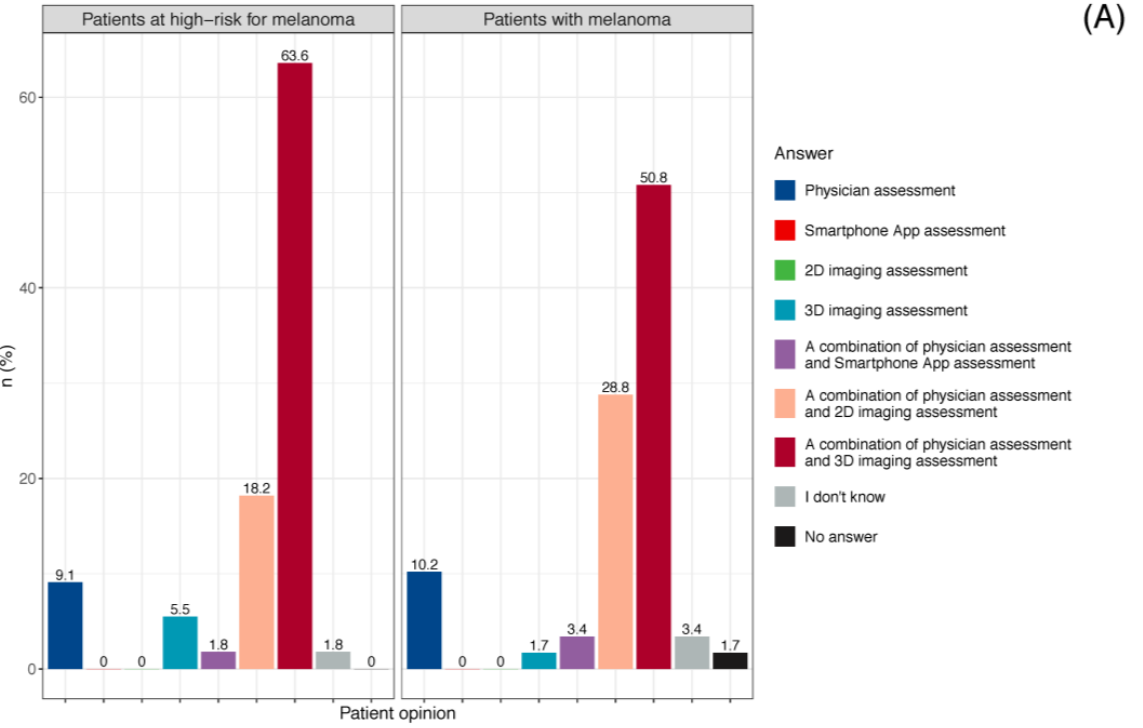
Figure 8. ( A ) Patient preference for mole assessment (patients at high-risk for melanoma, n = 55; patients with melanoma, n = 59); ( B ) Patient preference for AI in skin cancer screening (patients at high-risk for melanoma, n = 55; patients with melanoma, n = 59). Regarding patient preference for skin cancer screenings, almost all high-risk patients (98% (54/55)) and melanoma patients (95% (56/59)) indicated their belief that AI can im- prove a physician’s diagnostic performance. Most patients (64% (35/55) among high -risk patients, 54% (32/59) among melanoma patients) would prefer that the physicians would always consider the result of AI in their diagnosis (Figure 8B) (Supplementary Table S2).